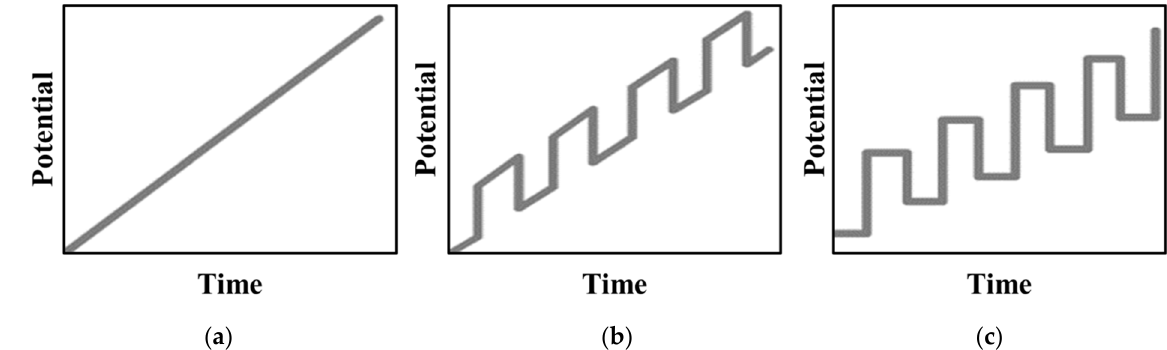
Figure 4. Profile of the potential versus time in ( a ) linear sweep, ( b ) differential pulse, and ( c ) square wave anodic stripping voltammetry (adapted from [62]).